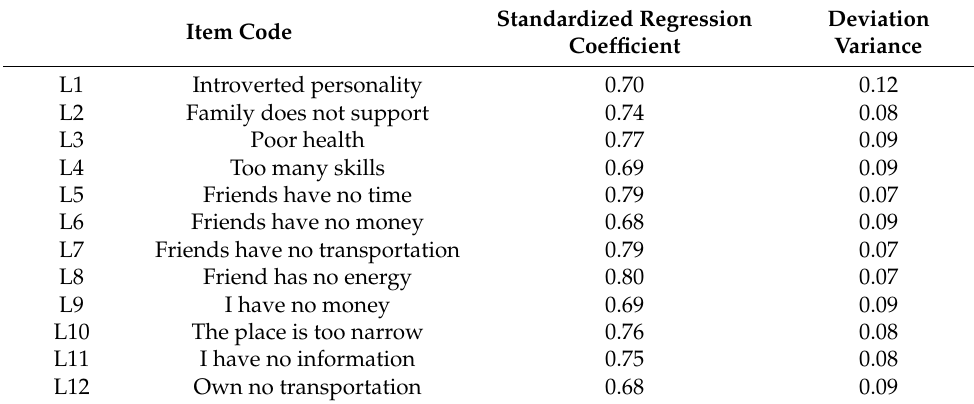
Table 2. Leisure hindrance scale offending estimate check table.